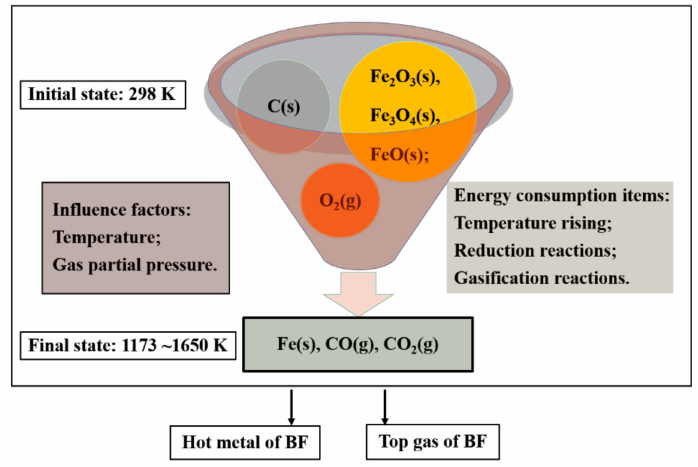
Figure 1. Schematic diagram of the initial state and the final state of ironmaking by carbon in the blast furnace (BF).